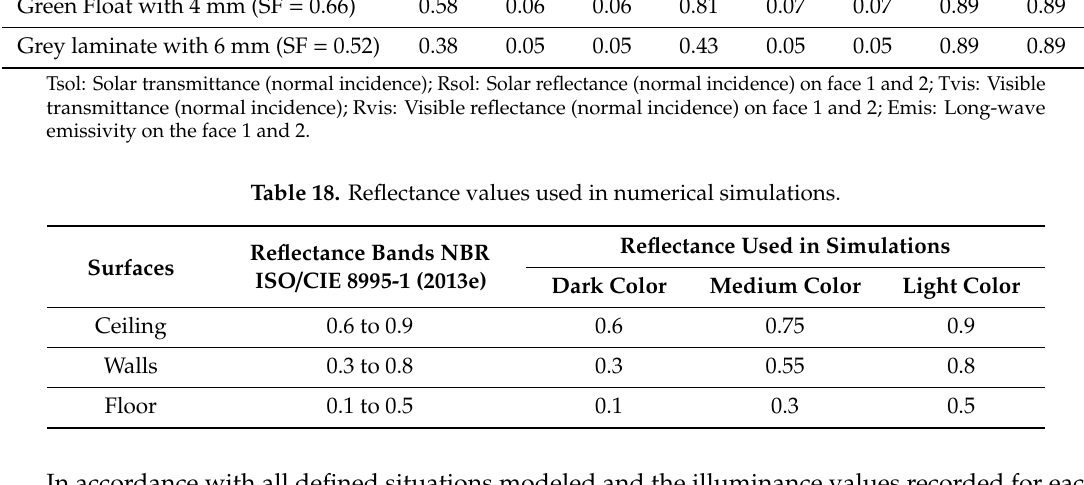
Table 17. Thermal property of translucent materials (glasses) used in the modeling and numerical simulation of thermal performance. Glass Tsol Rsol1 Rsol2 Tvis Rvis1 Rvis2 Emis1 Emis2 Colorless Float with 4 mm (SF = 0.85) 0.83 0.08 0.08 0.89 0.08 0.08 0.89 0.89 Green Float with 4 mm (SF = 0.66) 0.58 0.06 0.06 0.81 0.07 0.07 0.89 0.89 Grey laminate with 6 mm (SF = 0.52) 0.38 0.89